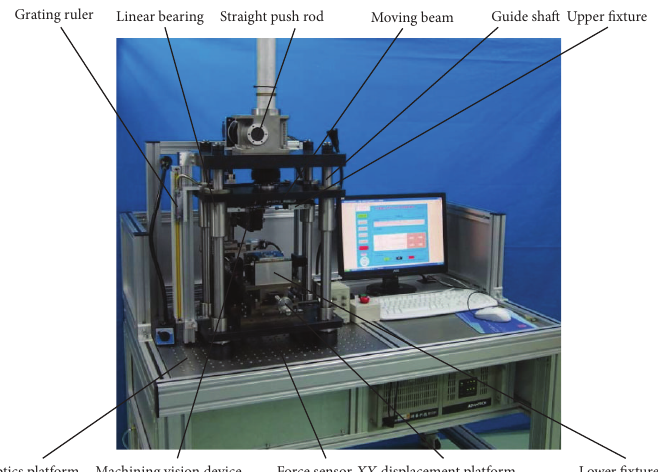
Figure 6: The press-mounting apparatus.